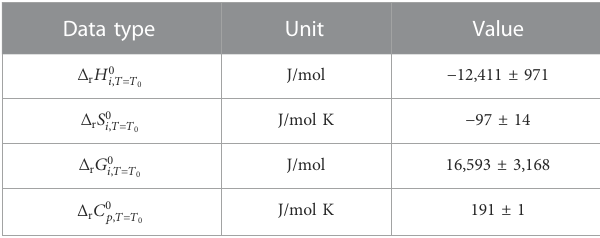
TABLE 4 Standard reaction data for O 2